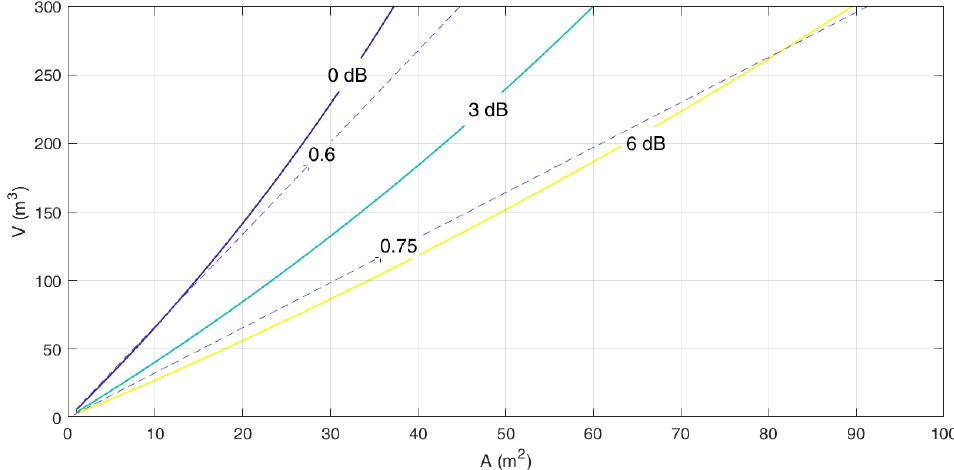
Figure 5. Prediction V – A diagram of speech intelligibility parameters in small-medium classrooms. C 50 contour lines are continuous; STI contour lines are dashed.